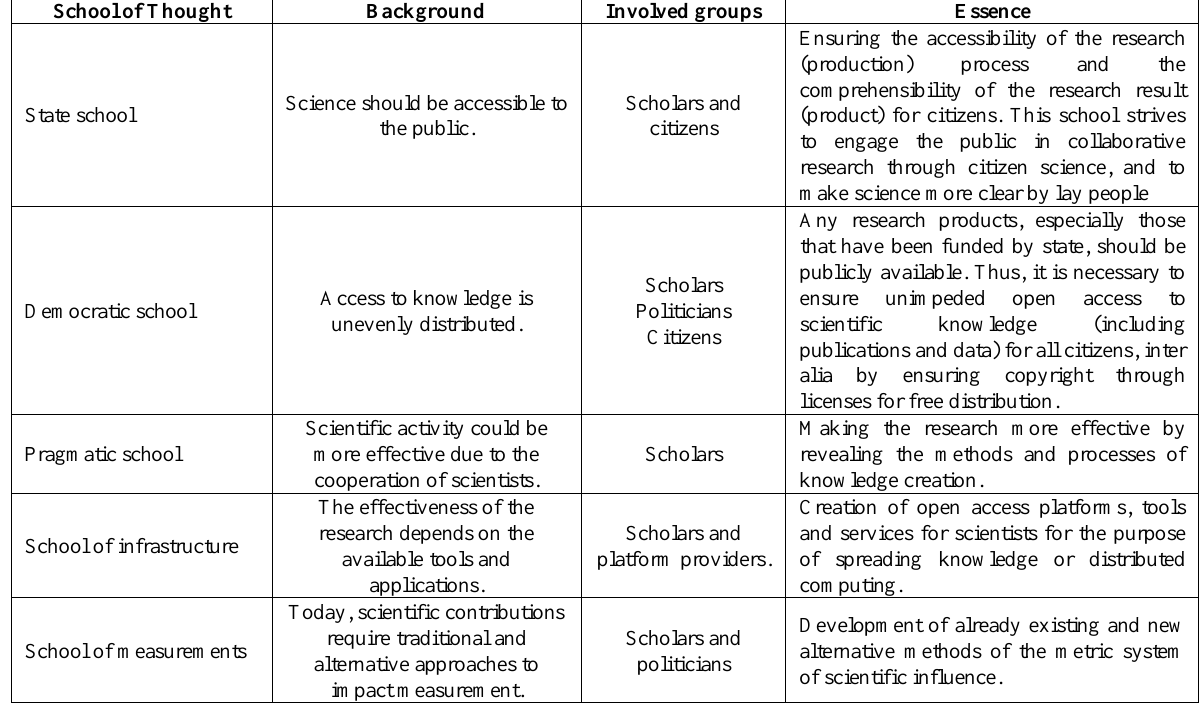
Table 1. Five Schools of Open